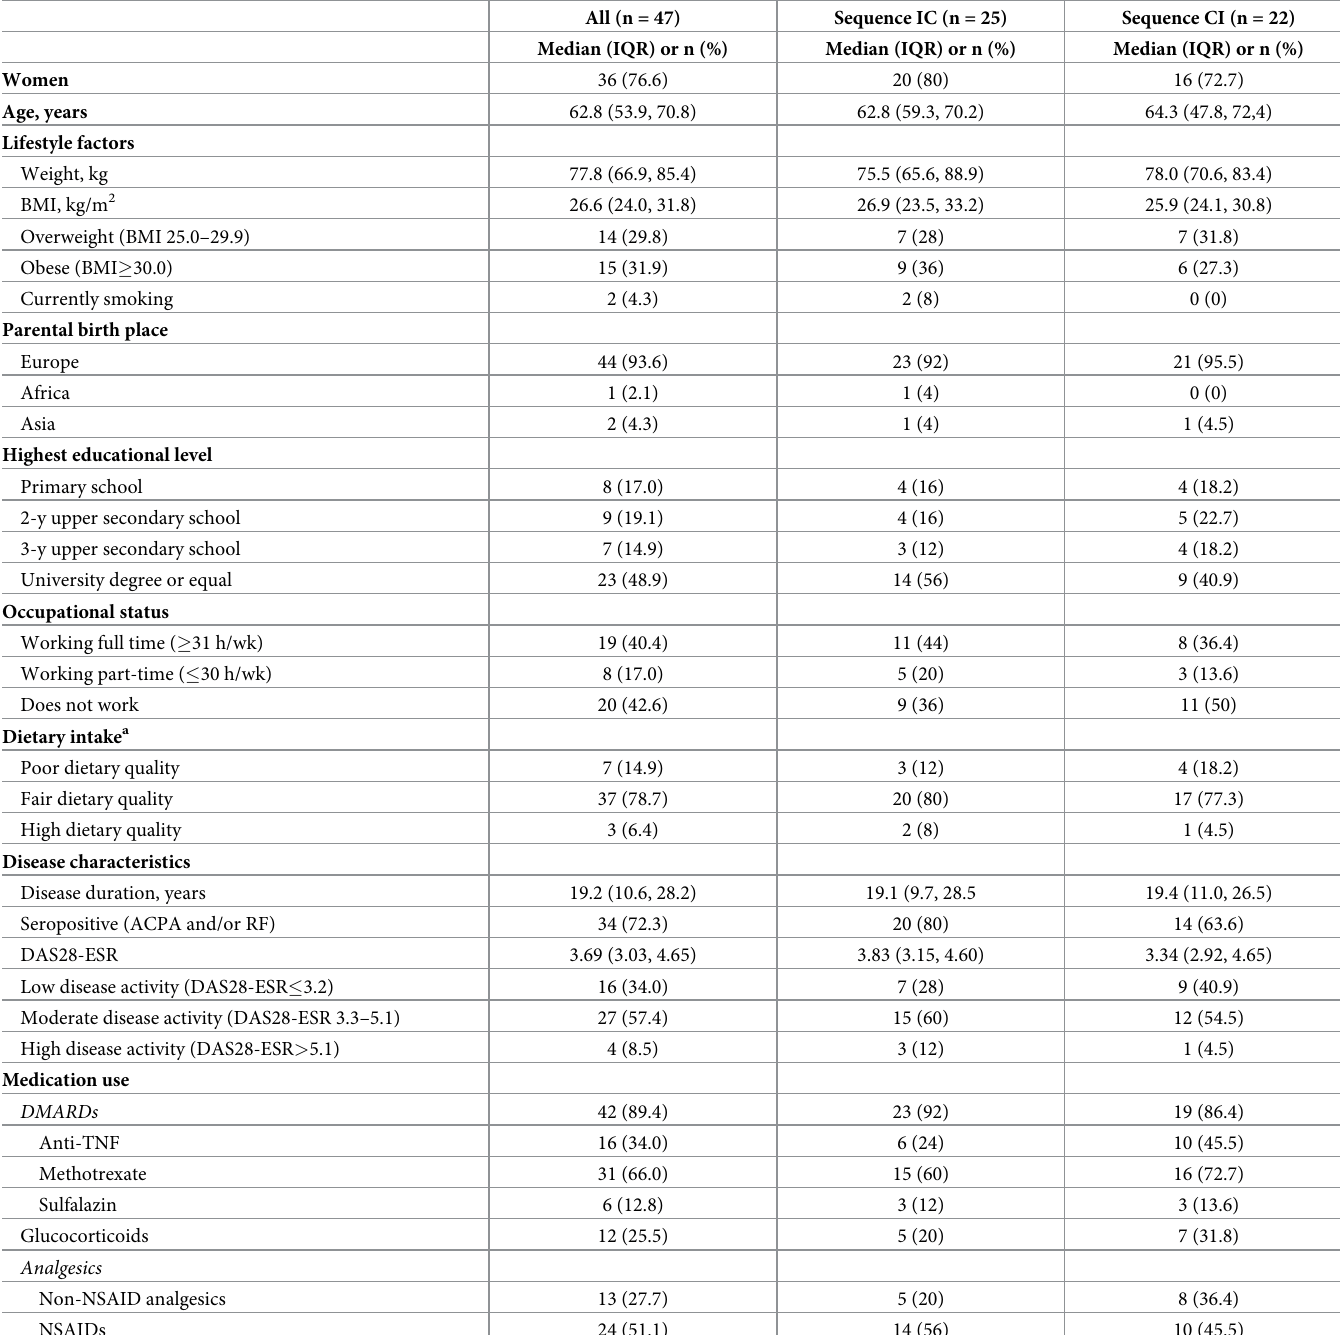
Table 1. Baseline characteristics of participants in the ADIRA